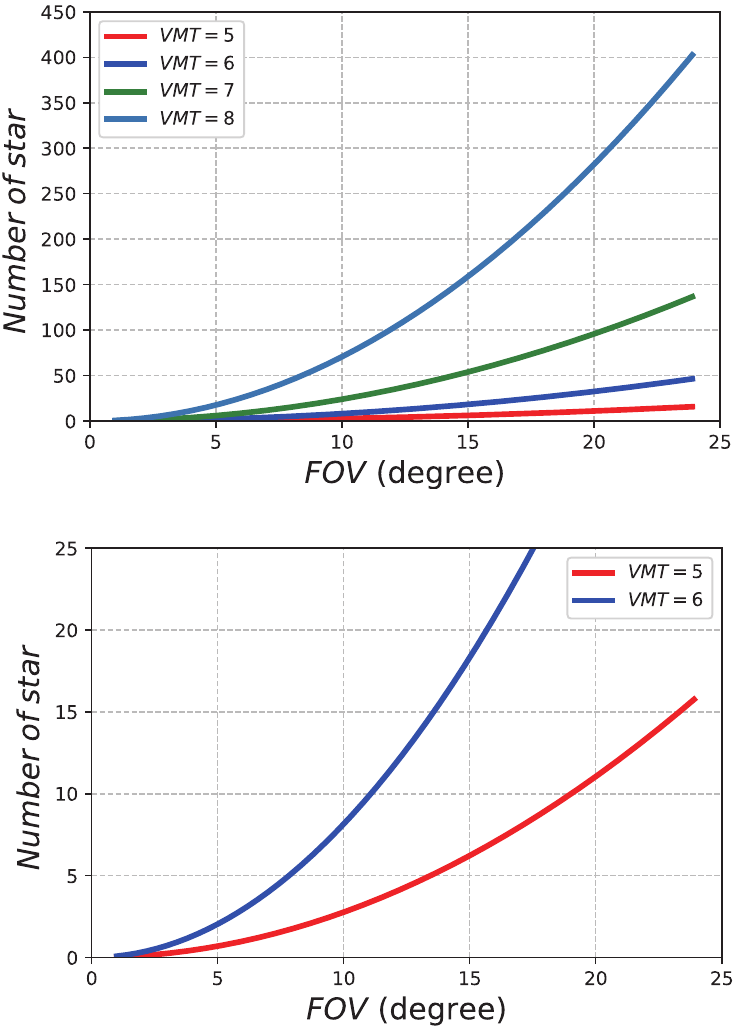
Figure 2. Average number of stars (NOS) for Different fields of view (FOVs) and visual magnitude thresholds